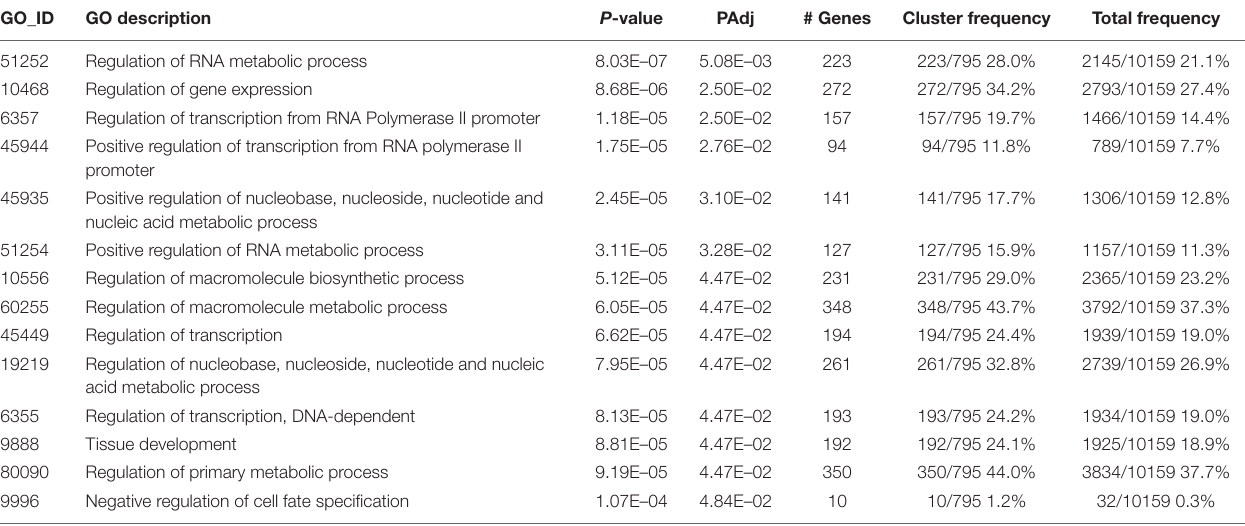
TABLE 2 | Significantly overrepresented biological process gene ontology terms in O. faveolata